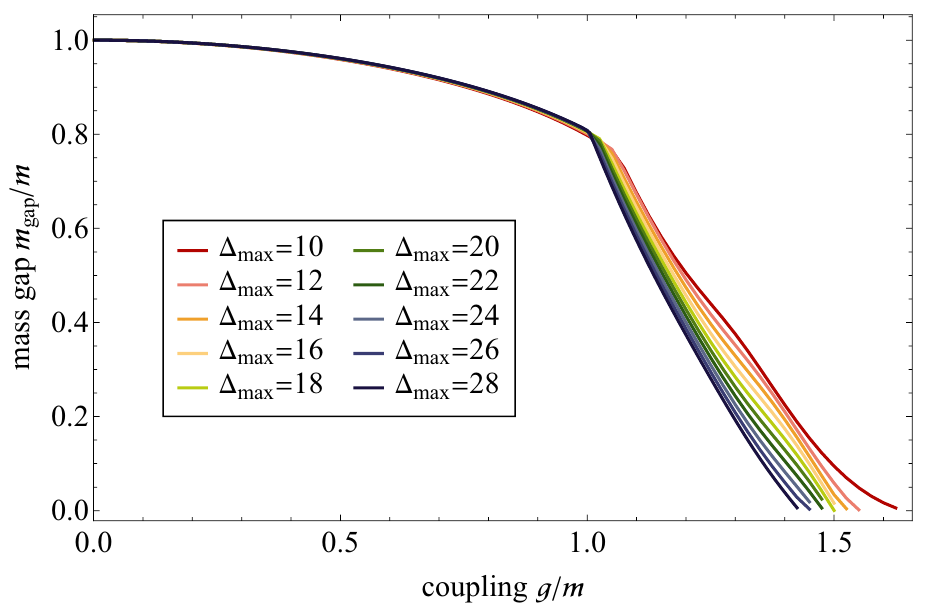
Figure 4 . The mass gap m gap as a function of the coupling g , at different ∆ max . At each ∆ max the mass gap is a smooth function of g , with one kink at g ≈ 1 where the continuum collides with the single particle state. The mass gap before the collision is almost the same for all ∆ max . As ∆ max increases (from red to blue), the coupling g at the collision moves to the left. The critical 0 coupling g where the gap closes also shifts to the left. The shape of the curve between g and g ∗ 0 ∗ deforms for small ∆ max and stabilizes for large ∆ max